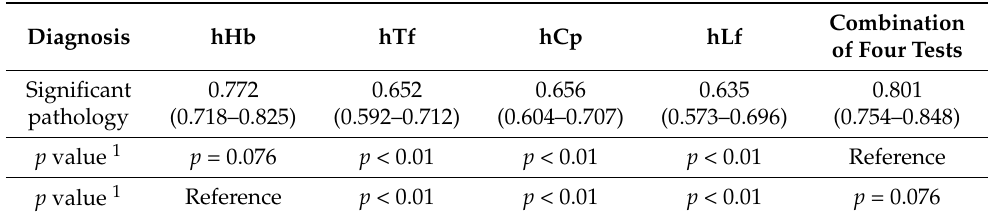
Table 5. AUCs (95%CI) of each biomarker of the combined POC faecal test and the combination for the diagnosis of significant colonic pathologies.